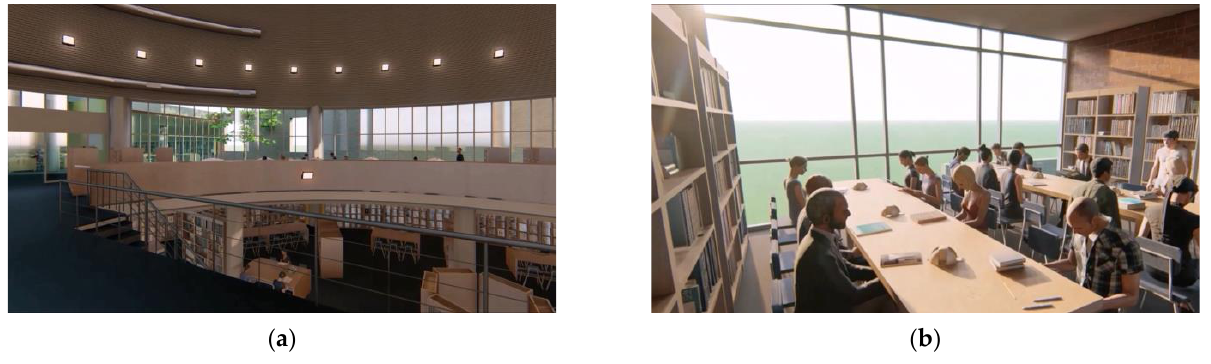
Figure 8. Frames of the virtual tour of the BIM model, included in the video tutorial of the system. (a) View of rooms on the ground floor and basement, (b) View of first floor room.